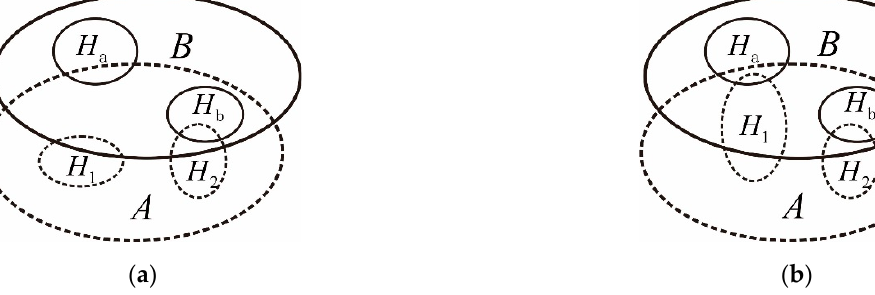
H is dis- a H overlaps H . 1 a